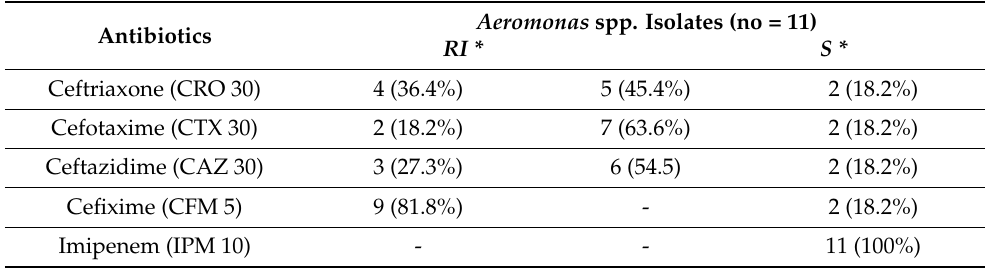
Table 4. Antibiotic suceptibilty of molecularly identified Aeromonas spp. against 16 antibiotics.